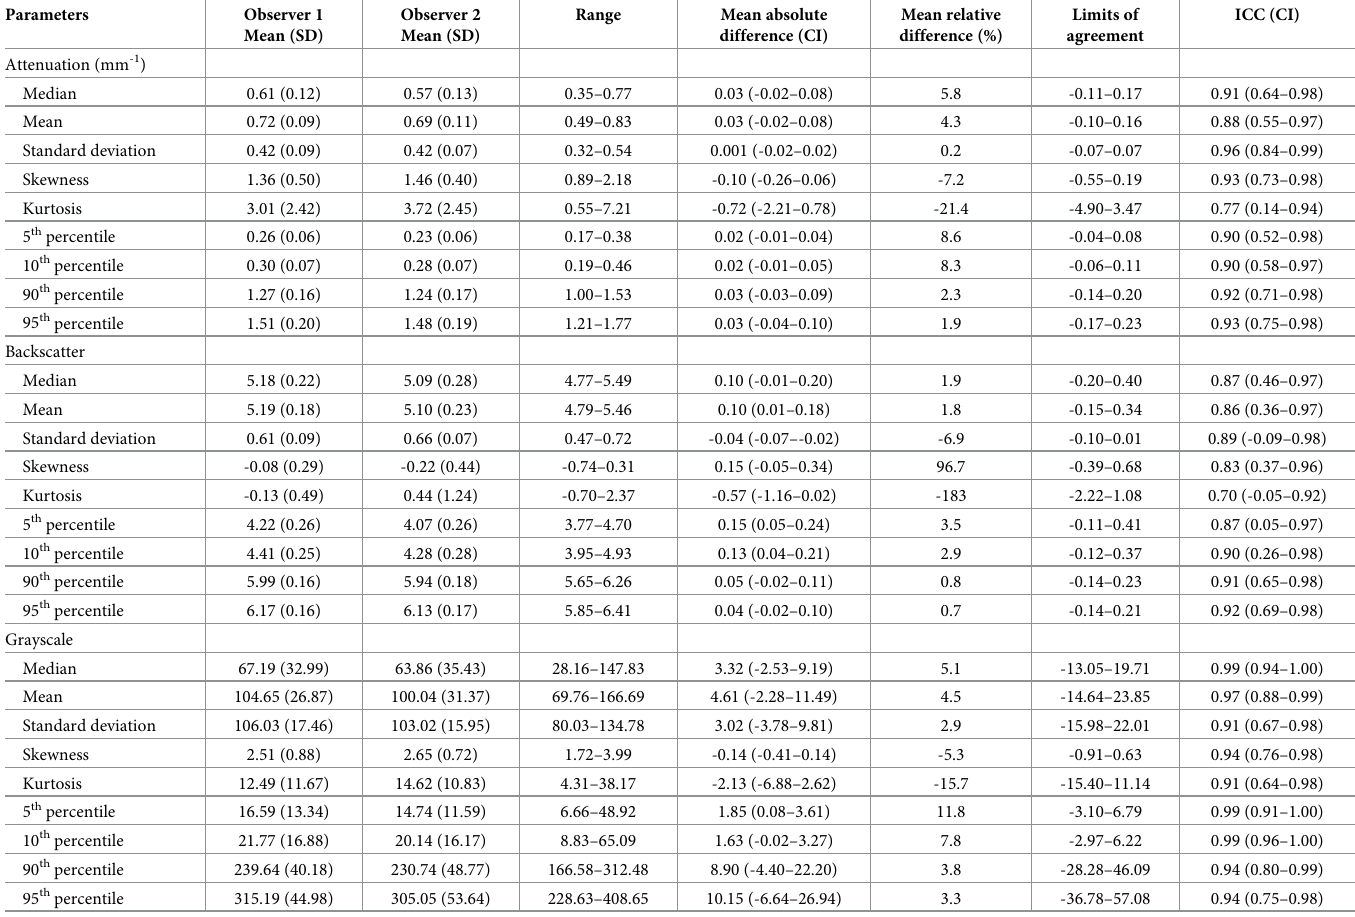
Table 2. Interobserver variability of QCU-CMS